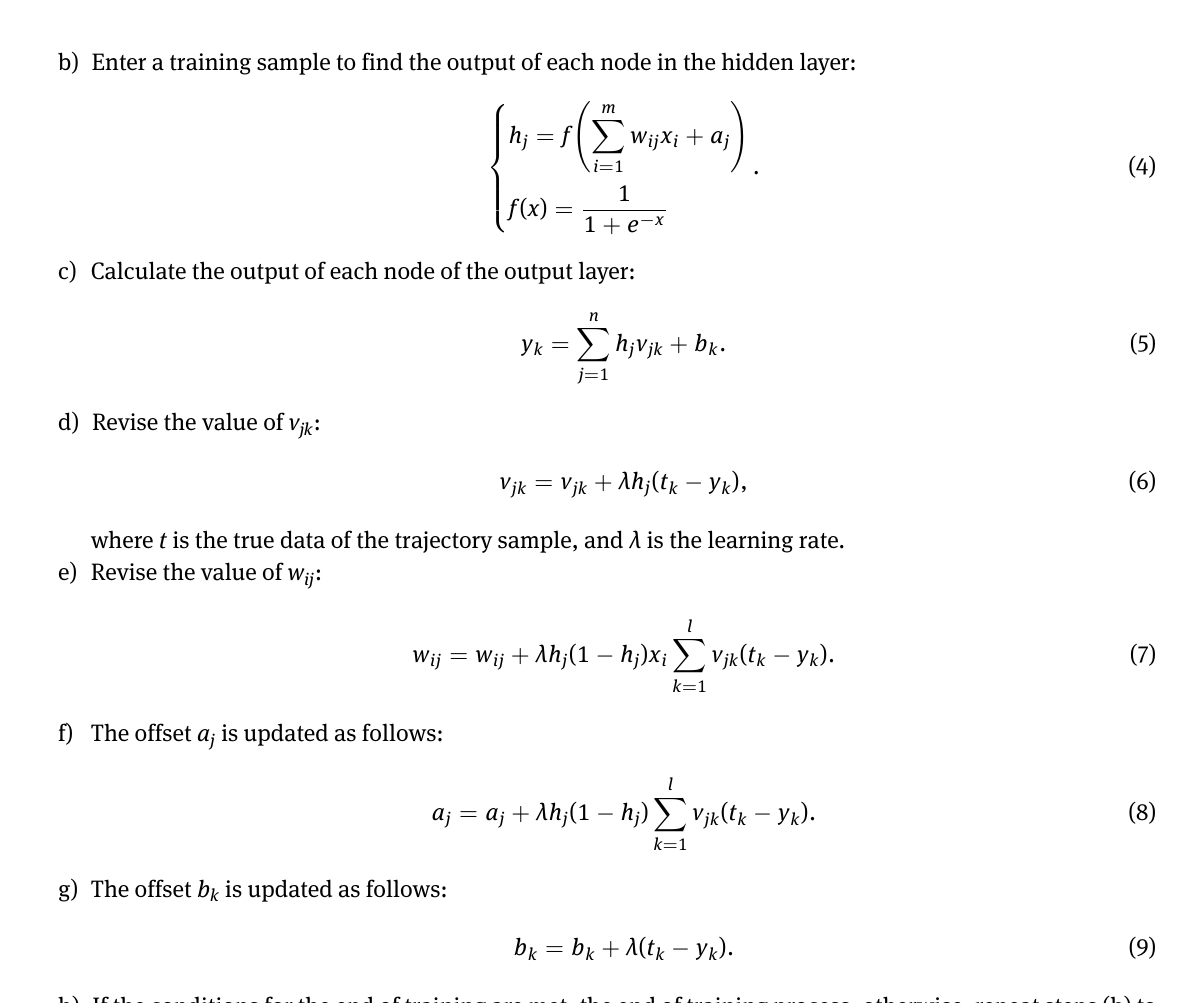
Figure3. Figure4 showsthe three-dimensionaldisplay ofthesetrajectory datain thecoordinates oflongitude, latitude and